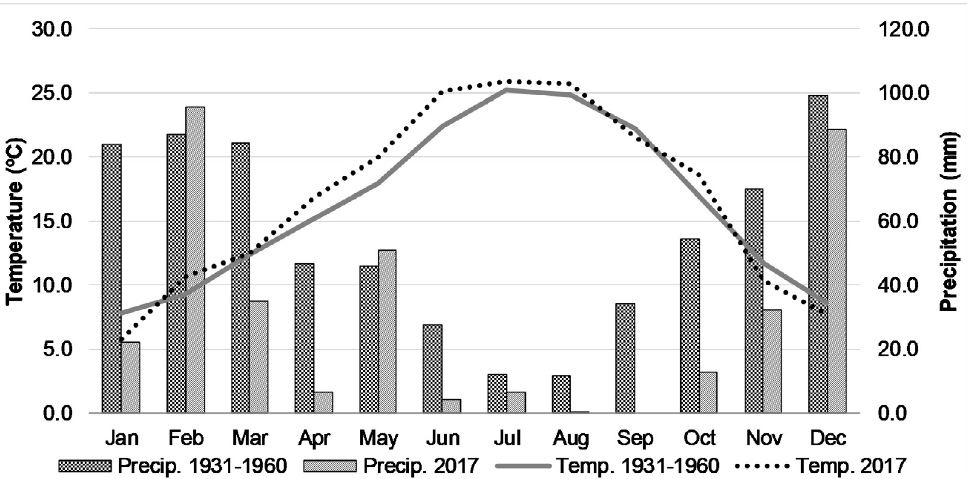
Figure 1: Temperature and precipitation characterization of the Douro wine region for the 30-years period between 1931-1960 Ferreira (1965) and comparison with the temperature and precipitation records in 2017 during study